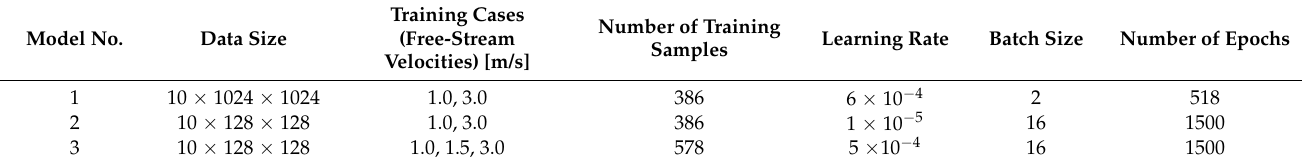
Table 4. Datasets and training parameters used to develop each CNN model.